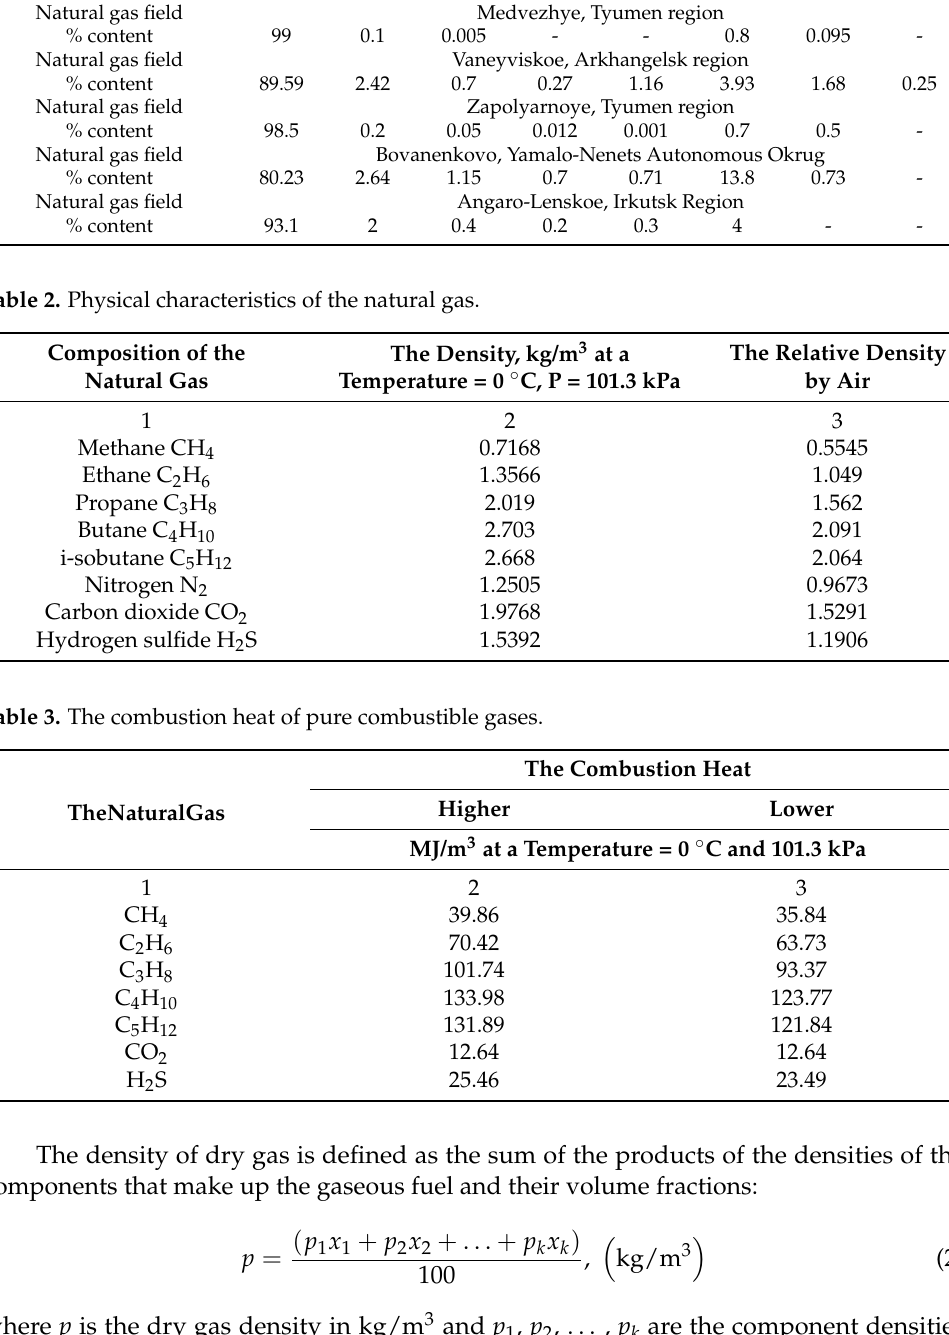
Table 1. The composition of natural gas by volume for various fields. The Component of Natural Gas